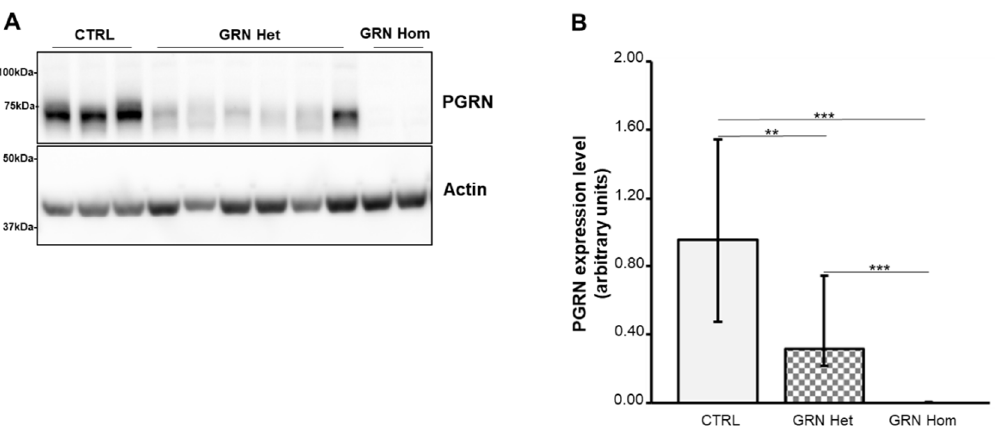
Figure 1. PGRN content in LCLs from WT controls and heterozygous and homozygous GRN mutation carriers. ( A ) A representative Western blot is shown. ( B ) Densitometric analysis of PGRN. Actin was used as the loading control. The graph represents medians with interquartile ranges (25–75%). Data are from six independent experiments in three WT and nine GRN -mutated LCLs. Statistical analysis by Mann–Whitney test, ** p < 0.01; *** p < 0.001. Het = heterozygous; Hom = homozygous.